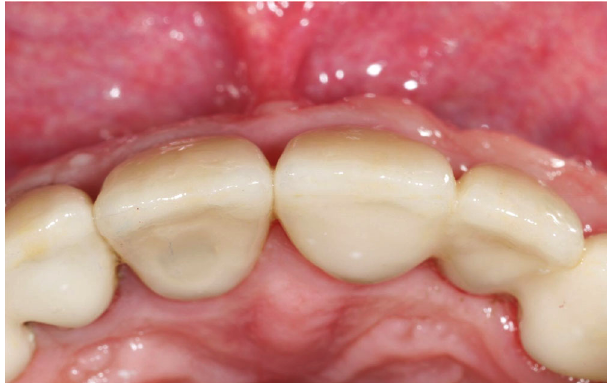
Figure 13: The occlusal view on the tooth #11 and the soft tissue adaptation to the fi nal